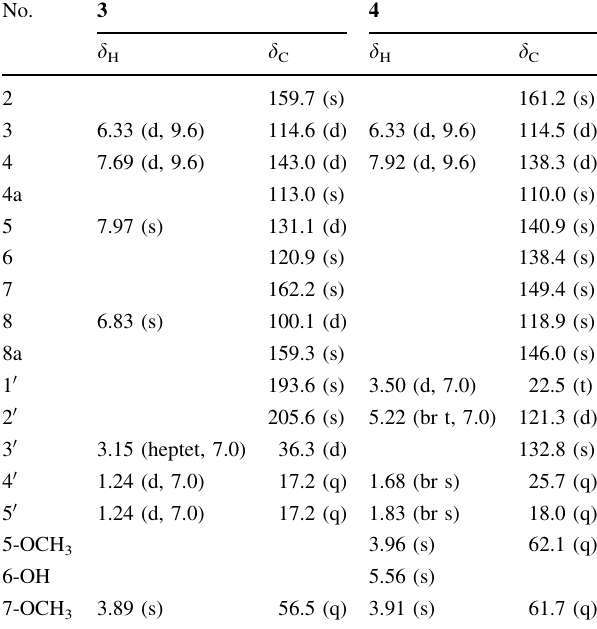
Table 3 NMR spectroscopic data for 6-(3-methyl-2-oxobutyroyl)-7- methoxycoumarin ( 3 ) and 6-hydroxycoumurrayin ( 4 ) in CDCl 3 ( d H 7.26,